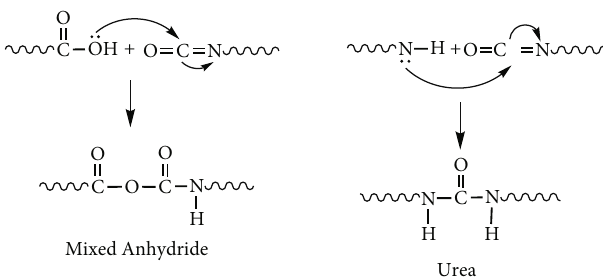
Figure 5: The reaction between free isocyanate of polymer chain with functional groups on NGQD.